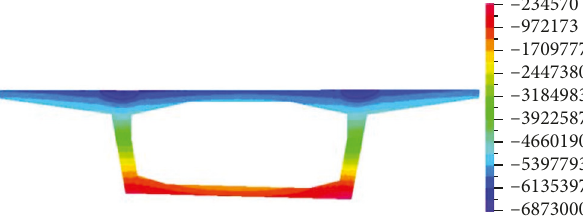
Figure 21: Longitudinal stress in the mid-span section of optimized 40 m box girder (Pa).